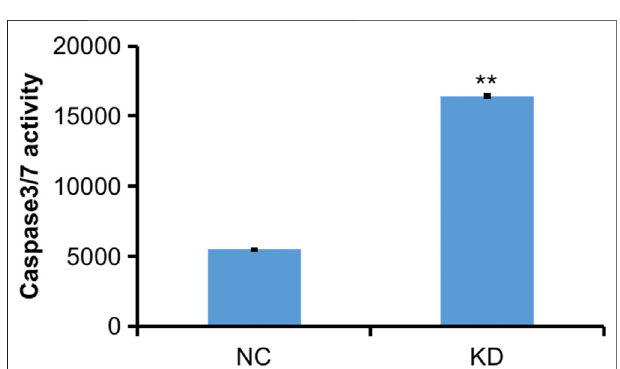
FIGURE 12 | Caspase 3-7 analysis of HBVSMCs transfected with control or hsa_circ_0005505 shRNAs. KD (cid:1) knockdown of hsa_circ_0005505, NC (cid:1) negative control. * p < 0.05, ** p < 0.01, *** p <